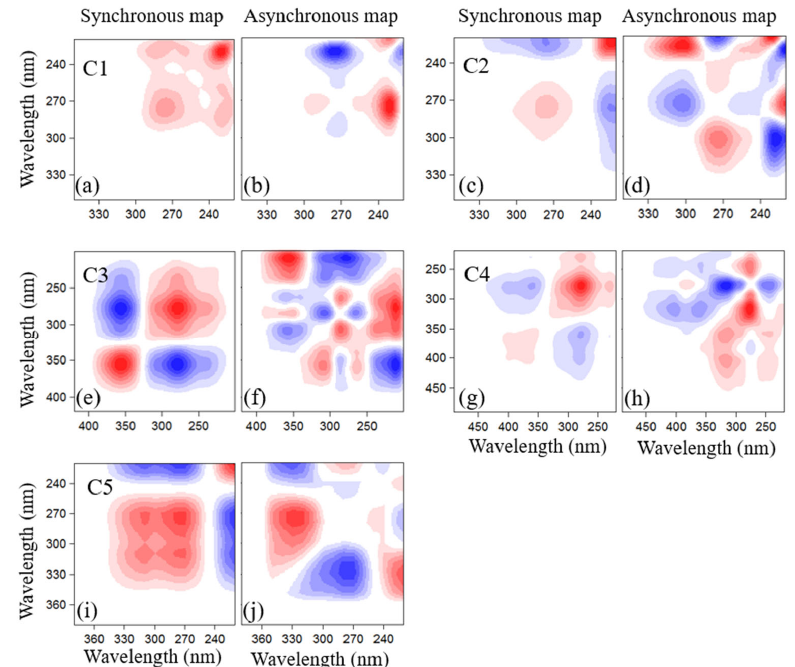
Figure 3. Synchronous and asynchronous 2DCOS analysis characterized by excitation loadings data originating from each DOM PARAFAC component. (Note: Positive and negative cross ‐ peaks were presented in red and blue.) Synchronous maps for components C1 to C5 were presented in Figure 3 a, c, e, g and i. Asynchronous maps for components C1 to C5 were presented in Figure 3 b, d, f, h, and